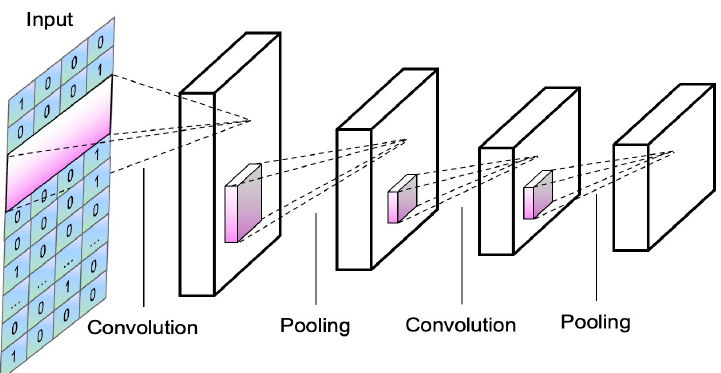
Figure 2. Structure diagram of the convolutional neural network (CNN) model.